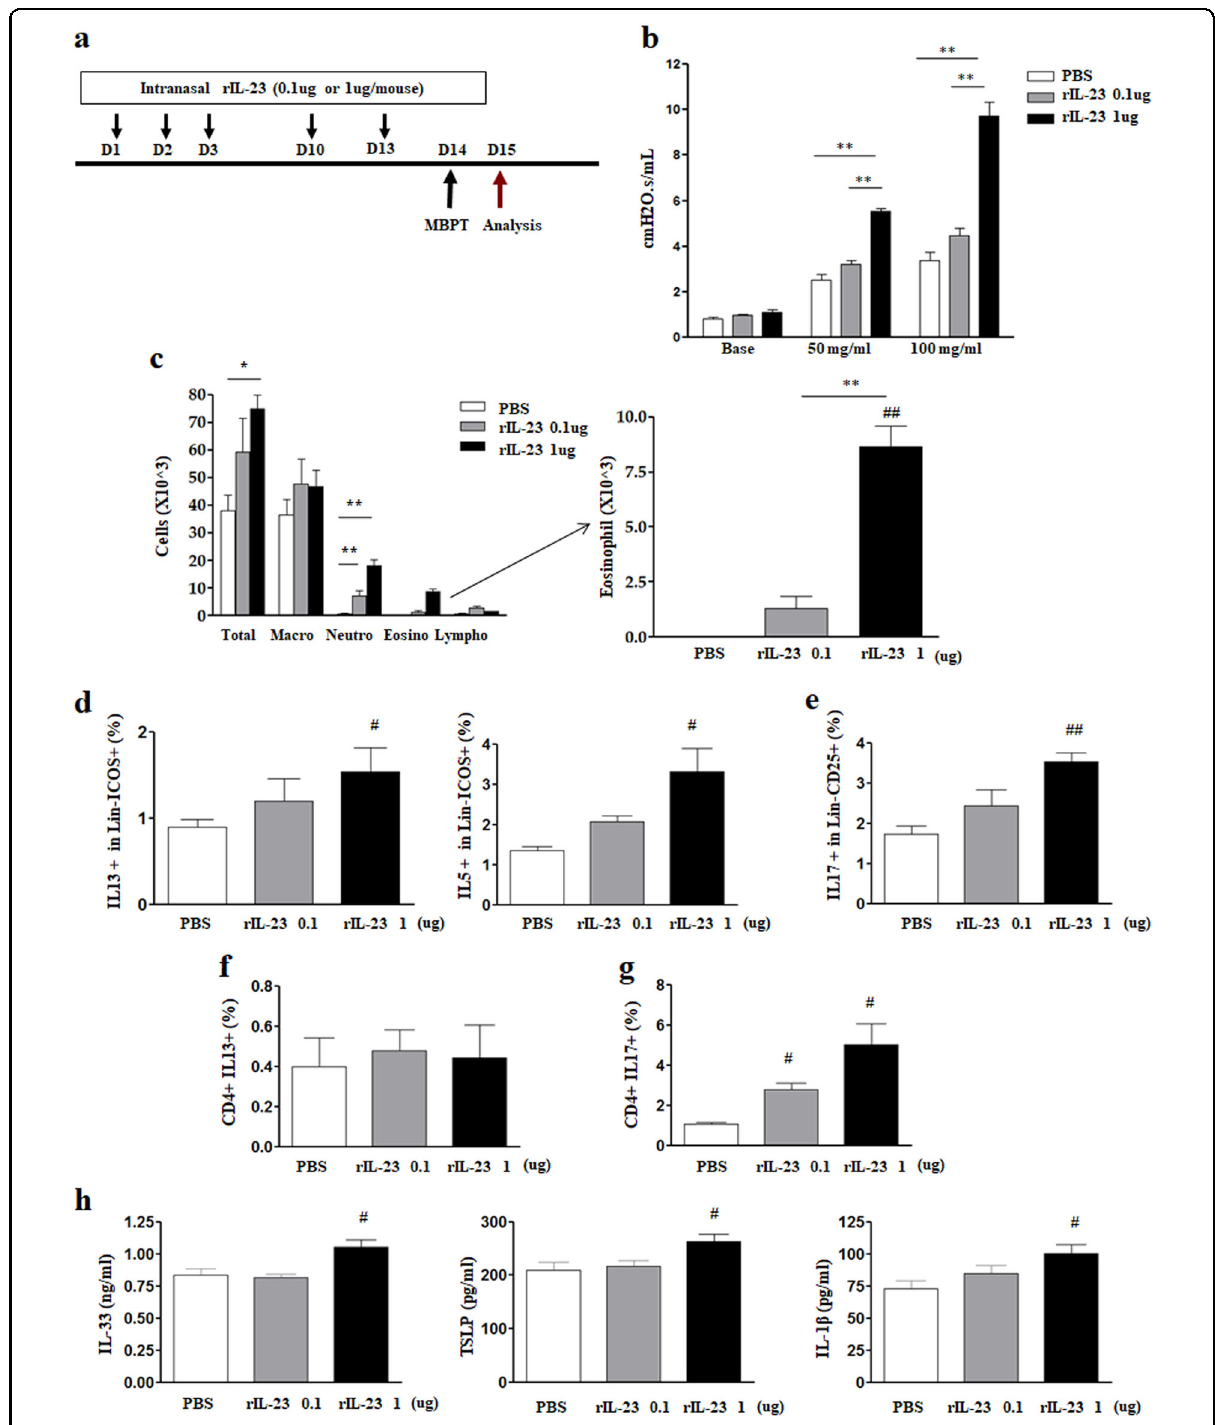
Fig. 1 Determination of recombinant interleukin-23 (rIL-23) dose for stimulation. a Experimental protocol. b Airway resistance at doses of 50 and 100 mg/mL methacholine (MCh). c In fl ammatory cells in bronchoalveolar lavage fl uid (eosinophils are magni fi ed). d IL-13-producing or IL-5- producing type 2 innate lymphoid cells (CD45 + Lin − ICOS + ) in lung homogenate. e IL-17A-producing type 3 innate lymphoid cells (CD45 + Lin − CD25 + ) in lung homogenate. f , g IL-13-producing or IL-17A-producing CD4 + T cells in lung homogenate. h IL-33 and TSLP levels in lung homogenate. * P < 0.05, ** P < 0.01 between two groups; # P < 0.05, ## P < 0.01 compared to the control group; AHR airway hyperresponsiveness; PBS phosphate-buffered saline; Macro macrophage; Neutro neutrophil; Eosino eosinophil; Lympho